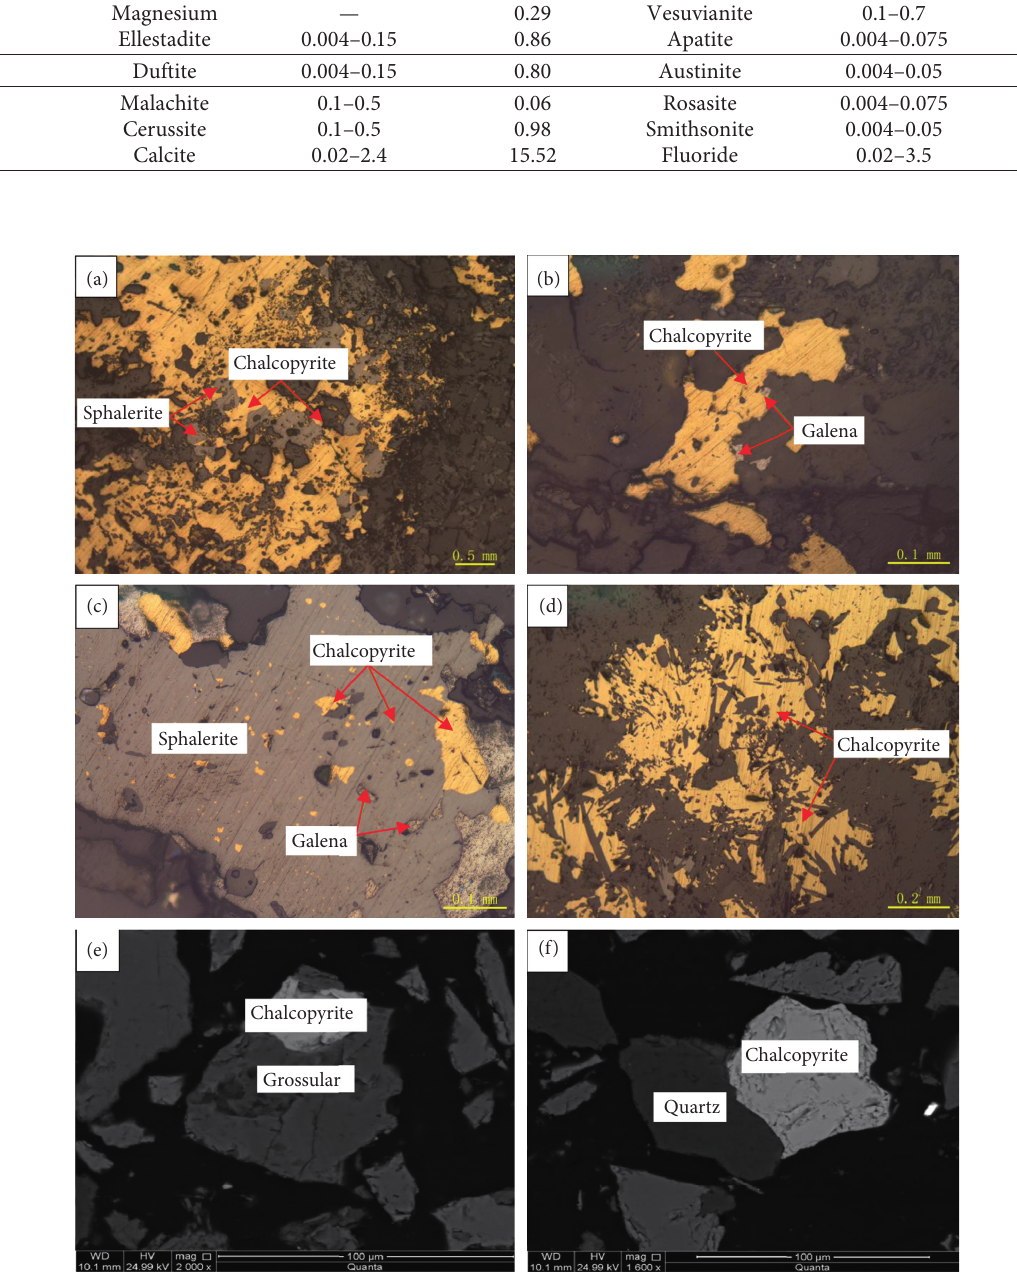
Figure 2: Embedded characteristics of